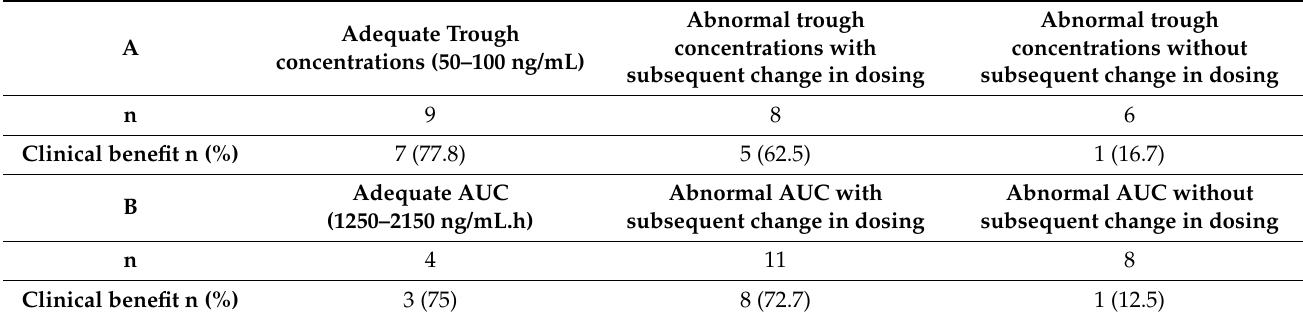
Table 3. Clinical benefit as measured by RECIST criteria at 3 months in patients depending on their baseline exposure values ( A : target = trough concentrations, B : target = AUC) with or without change in